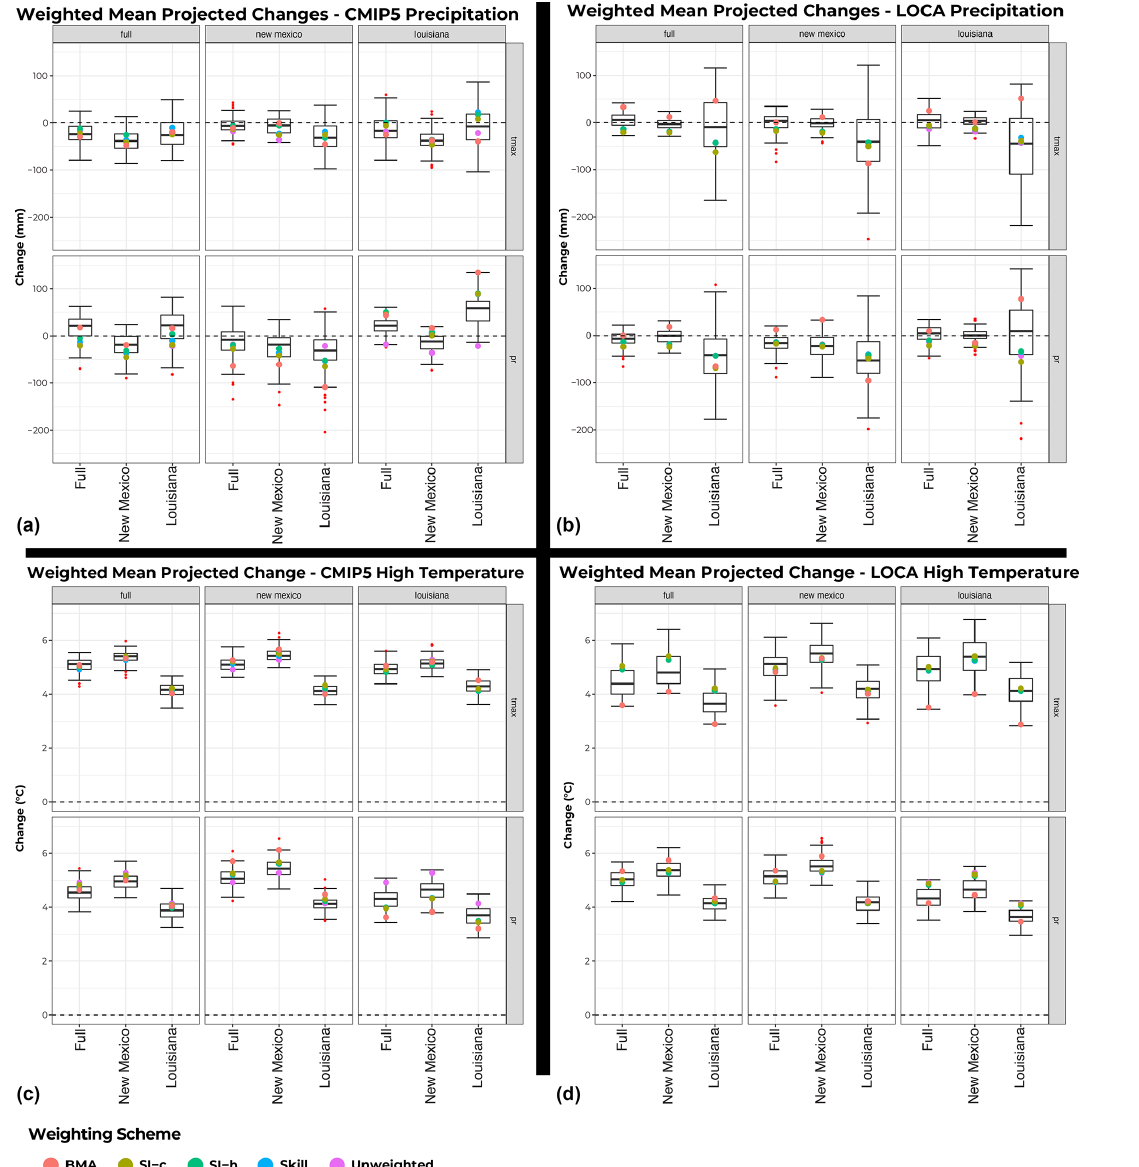
Figure 6. Mean projected changes in temperature and precipitation using all 48 weighting schemes, applied to all three domains and both variables (tmax and pr). Panels (a, b) focus on pr, panels (c, d) focus on Tmax, (a, c) on the CMIP5 ensemble, and (b, d) on the LOCA ensemble. In an individual group, the top row shows the results from weighting schemes derived with tmax, and the bottom row shows the results from weighting schemes derived with pr. In addition, within an individual group, the left column shows the results for weighting derived using the full domain, the middle column shows the results for weighting derived using the New Mexico domain, and the right column shows the results for weighting derived using the Louisiana domain. Within a given domain and variable, the results are shown from left to right for the domain the weights are applied to. The box plots are the results from the 100 BMA posterior